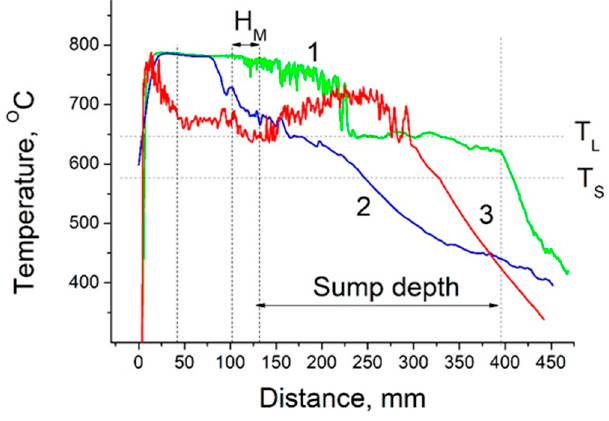
Figure 10. Variation of the melt temperature with distance from the melt surface. 1,2—FRHT without ultrasound irradiation, 3—FRHT with ultrasound irradiation.